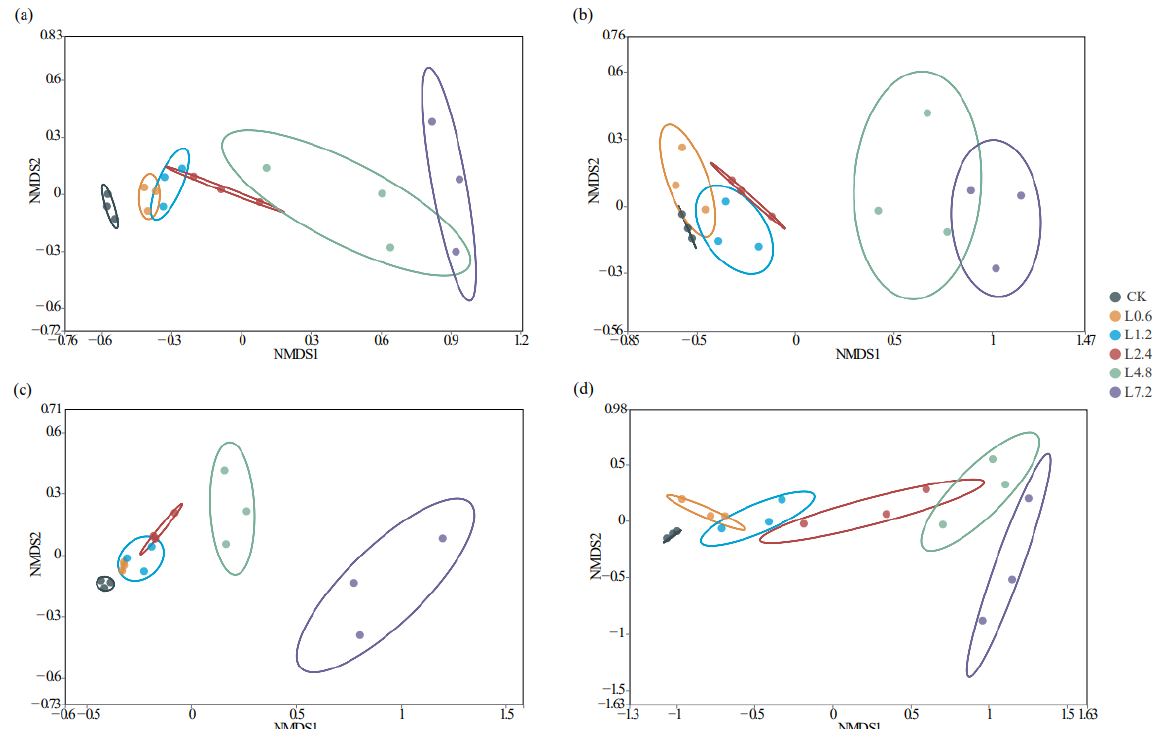
Figure 5. Differential analysis of the structure of the four soil bacterial communities under different lime treatments. The letters ( a – d ) represent soil types. The differences between soil microbial communities of different treatments can be judged by the distance between treatments: the longer the distance, the greater the differences in microbial community composition.